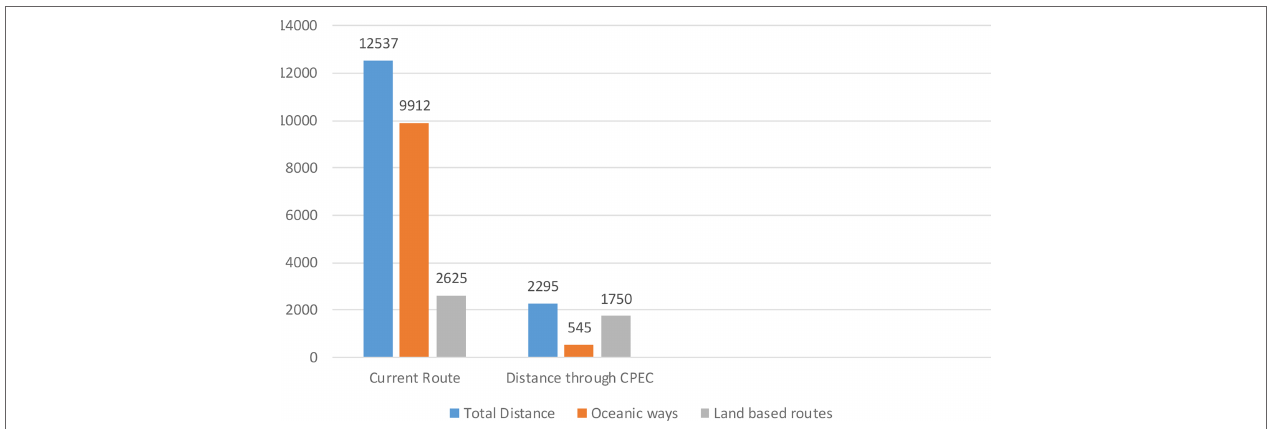
FIGURE 2 | Comparison of Mileage between the Current Route and Proposed Route under CPEC Project (Abu Dhabi to Shanghai, in Miles). Source:Created by the